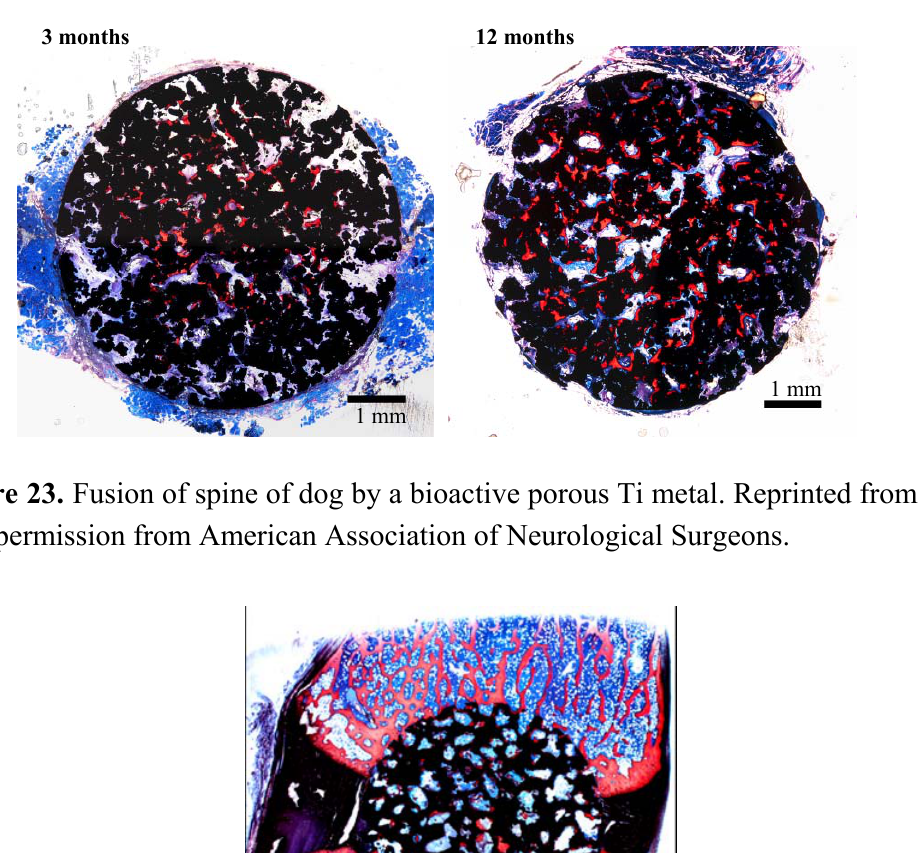
Figure 22. Bone formation in porous Ti metal subjected to NaOH, HCl and heat treatments, 3 and 12 months after implantation into muscle of beagle dog. Stain: Stevenel’s blue and Van Gieson’s picrofuchsin. Reprinted from Ref. [20] with permission from Elsevier.